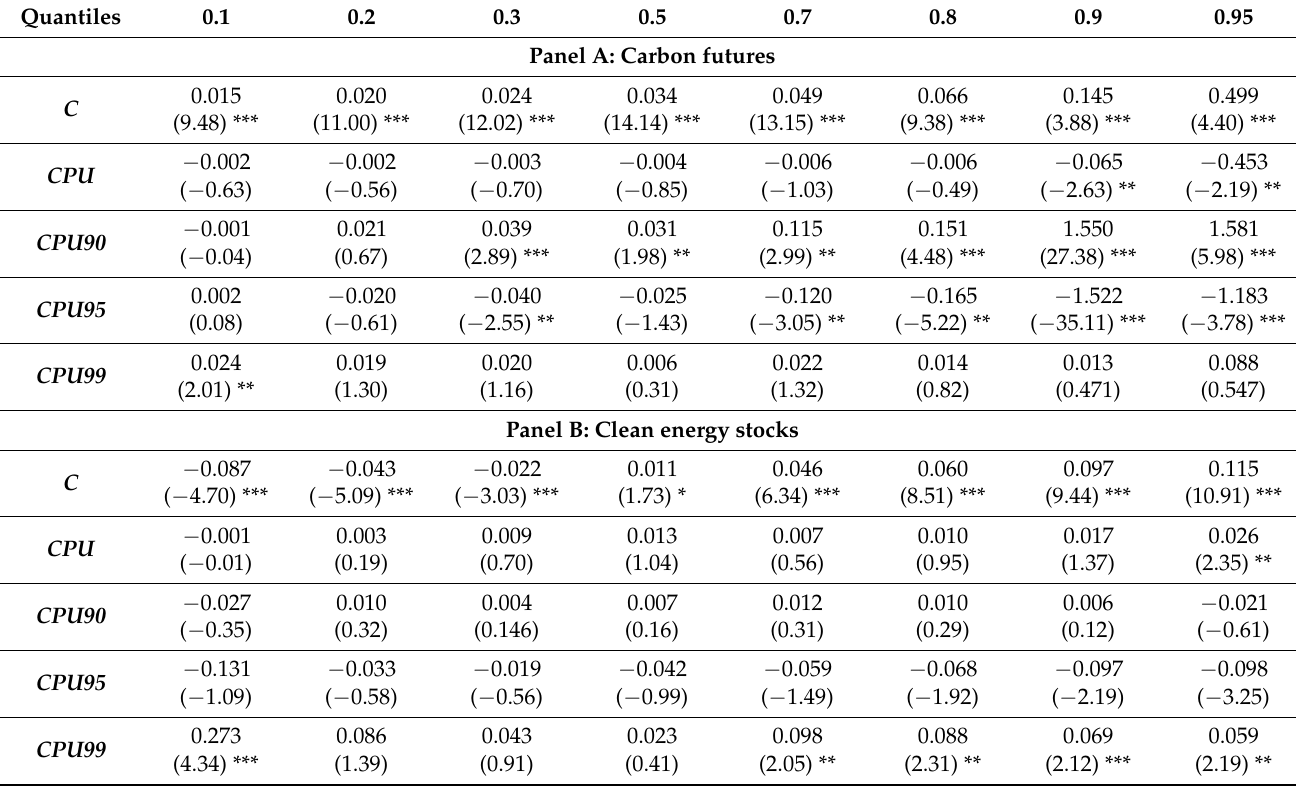
Table 3. Quantile regression with